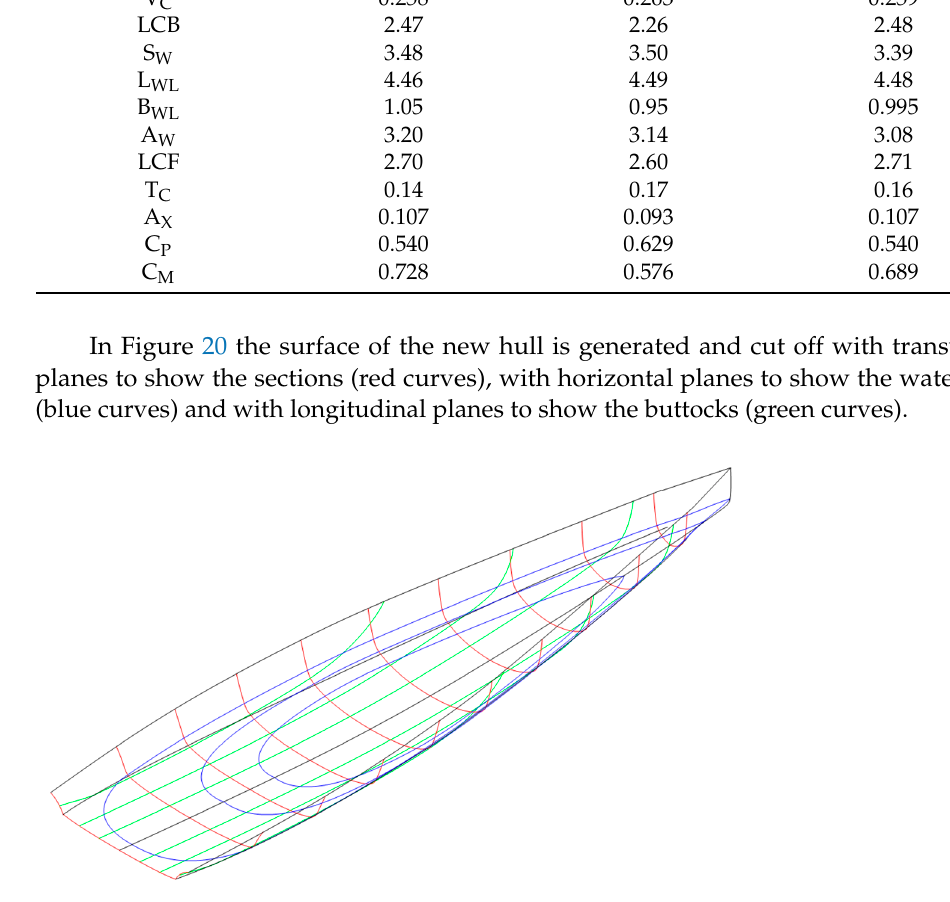
Figure 20. Surface of LED_UP_06.